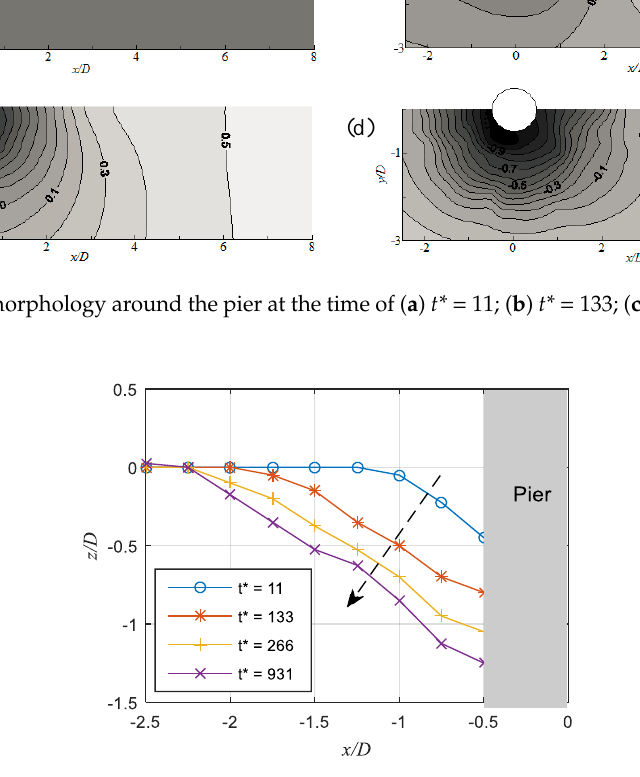
Figure 4. Scour profile along the centerline in front of the pier at different time .